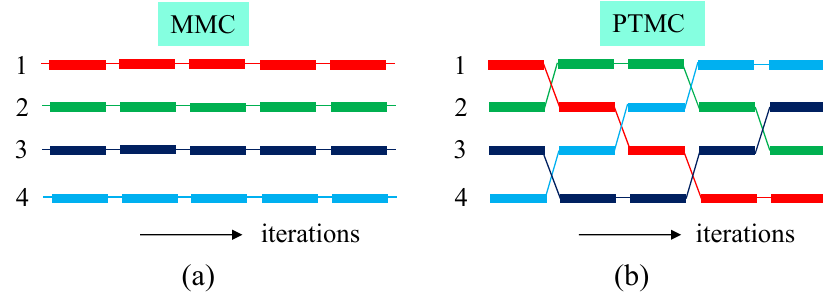
Figure 5. Illustration of how the replica systems evolve in ( a ) MMC and ( b ) PTMC simulations. In ( a ) MMC simulations, each system evolves independent of the other systems, while in ( b ) PTMC simulations, the systems are